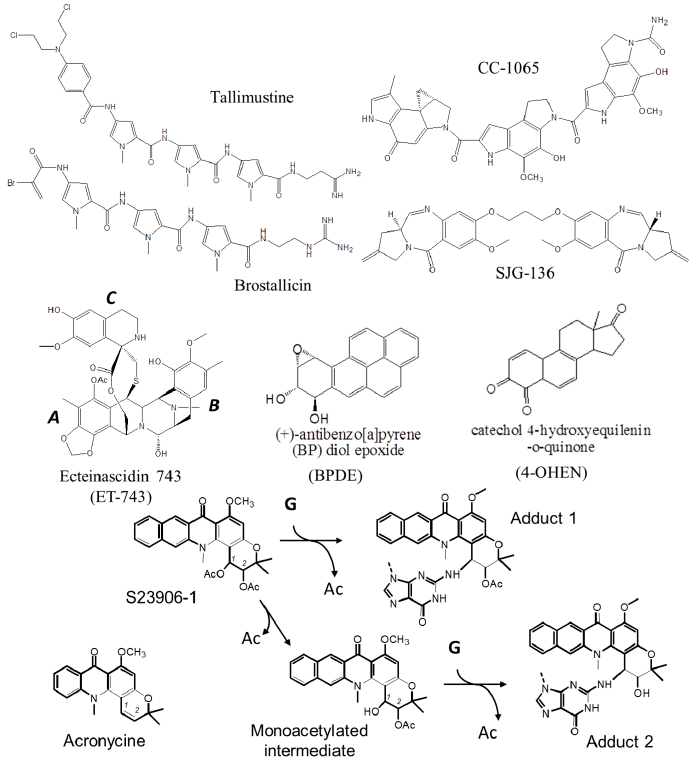
Figure 2. Structures of the DNA minor groove alkylating agents described in the text and S23906-1/DNA alkylation process. The covalent reaction with a guanine (“G”) leads to a concomitant release of one acetate group